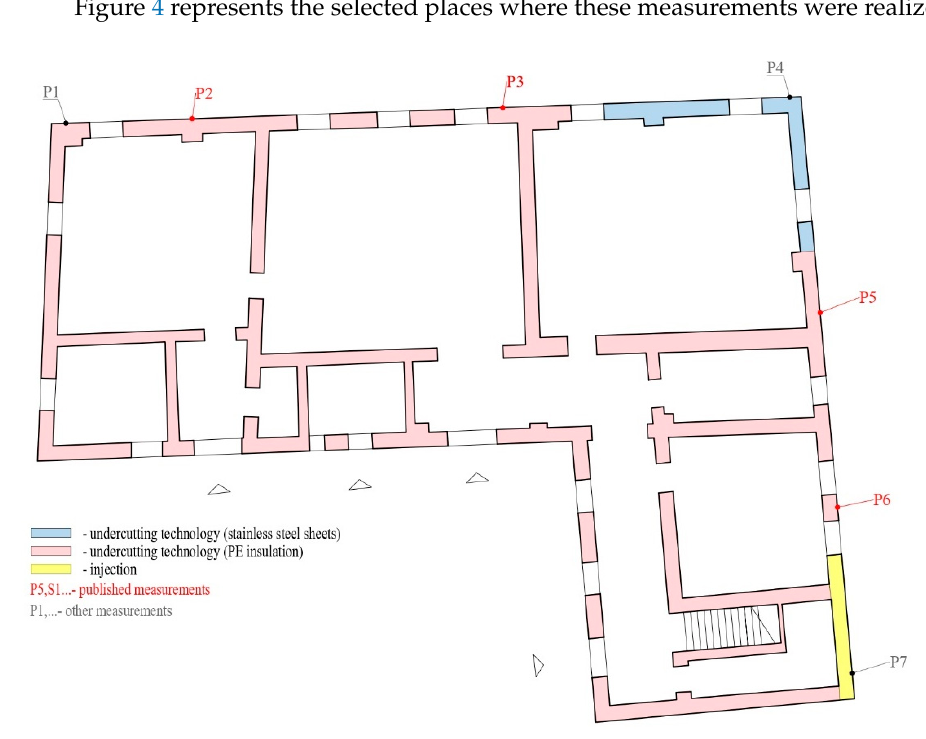
Figure 4. Humidity measurement points (1st researched building).